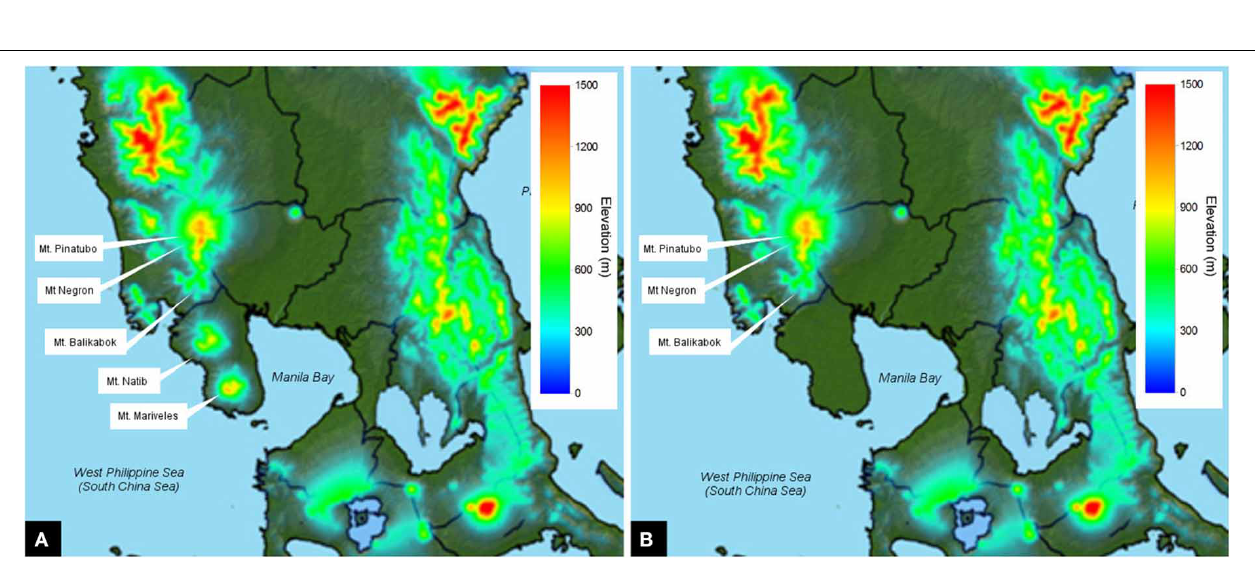
FIGURE 3 | Topography used in the WRF model (A) with Natib and Mariveles Volcanoes (B) without Natib and Mariveles volcanoes.